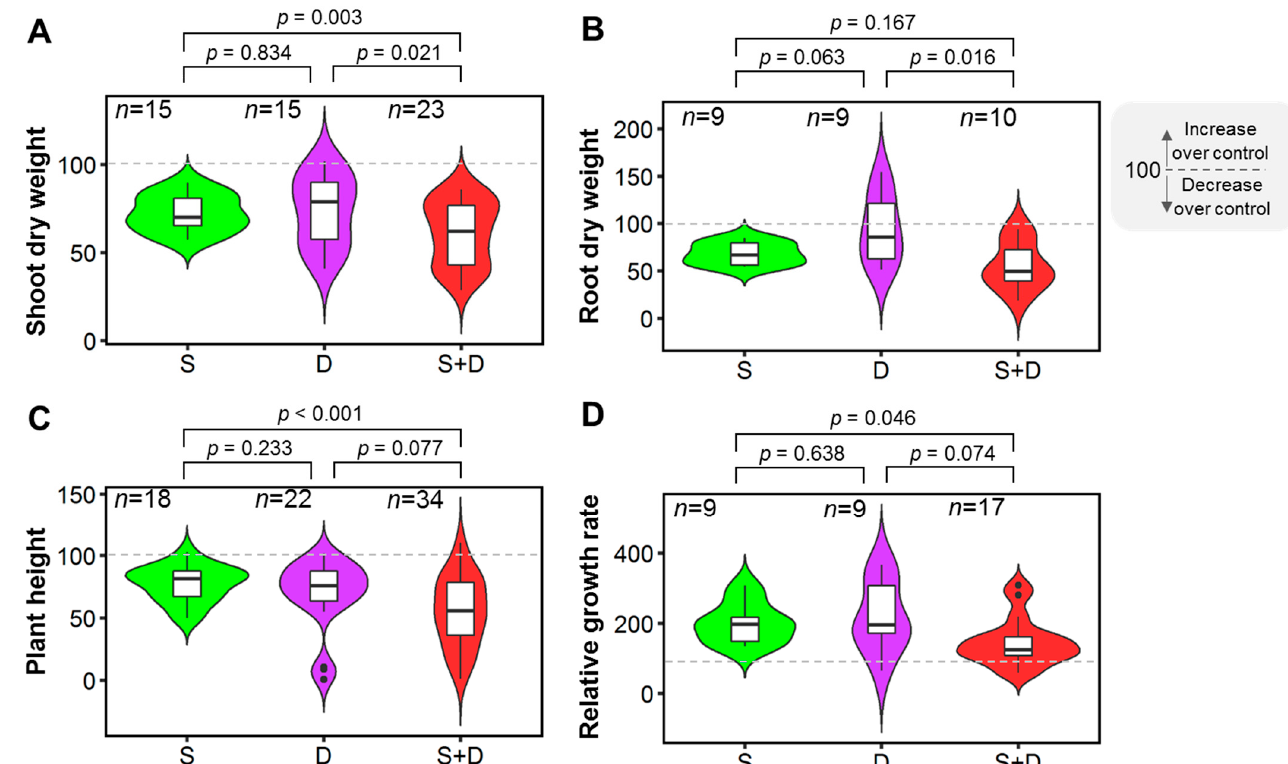
Figure 2. Effects of salinity (S), drought (D), and combined salinity and drought (S+D) stress on growth parameters. ( A ) Shoot dry weight (SDW), ( B ) root dry weight (RDW), ( C ) plant height (PH), and ( D ) relative growth rate (RGR). The % of control treatment is presented in the figures. The statistical differences were assessed using Welch’s t -test where the p -value indicates the level of statistical difference, and a p value less than 0.05 was considered statistically significant. n indicates the number of